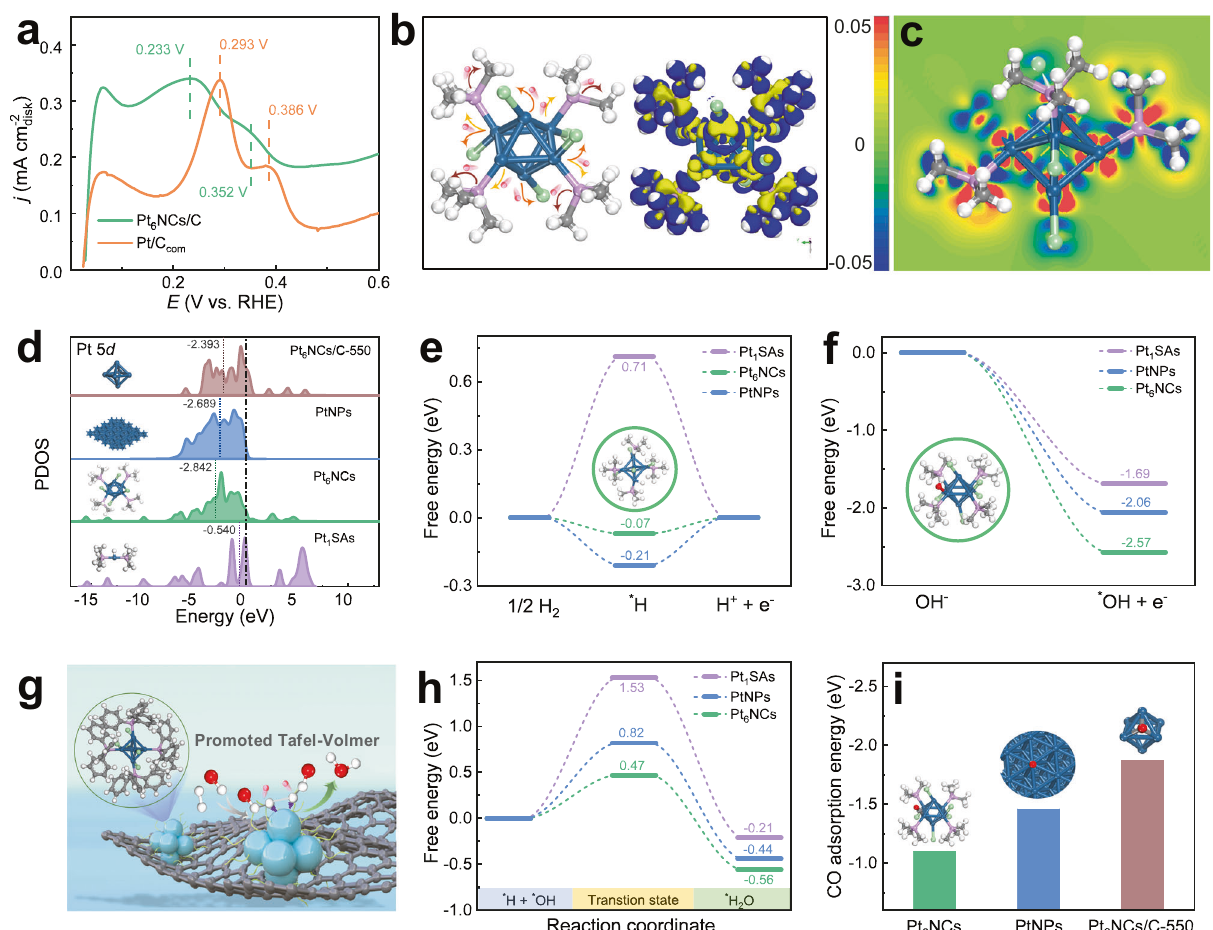
Fig. 4 Theoretical veri fi cation on the structure-activity relationship. a CV curves of Pt 6 NCs/C and Pt/C com , showing the hydrogen desorption region. b Simulated model of Pt 6 NCs (left) and electron density differences of Pt 6 NCs (right), where the blue and yellow represent accumulation and depletion of charge, respectively. c The slice perspective of differential charge density distribution for Pt 6 NCs based on DFT analysis. In the electron density difference maps, the red and blue colors refer to the positive (0.05 e Å − 3 ) and negative ( − 0.05 e Å − 3 ) values, respectively. d The PDOSs of Pt 5 d in Pt 1 SAs, Pt 6 NCs, PtNPs, and Pt 6 NCs/C-550 (each d -band center is marked by a dashed line) with the Fermi level aligned at 0 eV; inset: computed corresponding catalyst models. e Δ G *H on Pt 1 SAs, Pt 6 NCs, and PtNPs; inset: computed hydrogen adsorption con fi guration on Pt 6 NCs. f Δ G *OH on Pt 1 SAs, Pt 6 NCs, and PtNPs; inset: computed hydroxyl adsorption con fi guration on Pt 6 NCs. g Schematic illustration of HOR catalysis on the Pt 6 NCs/C. h The energy barrier for water formation on Pt 1 SAs, Pt 6 NCs, and PtNPs. i CO adsorption energy of Pt 6 NCs, PtNPs, and Pt 6 NCs/C-550; inset: computed CO adsorption con fi guration on Pt 6 NCs, PtNPs, and Pt 6 NCs/C-550. The gray, red, white, blue, pink, and reseda spheres represent C, O, H, Pt, P, and Cl atoms,